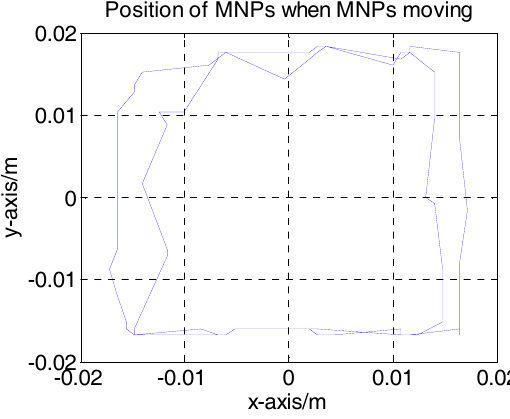
Figure 8. The trajectories of MNPs obtained from data of Figure 7.